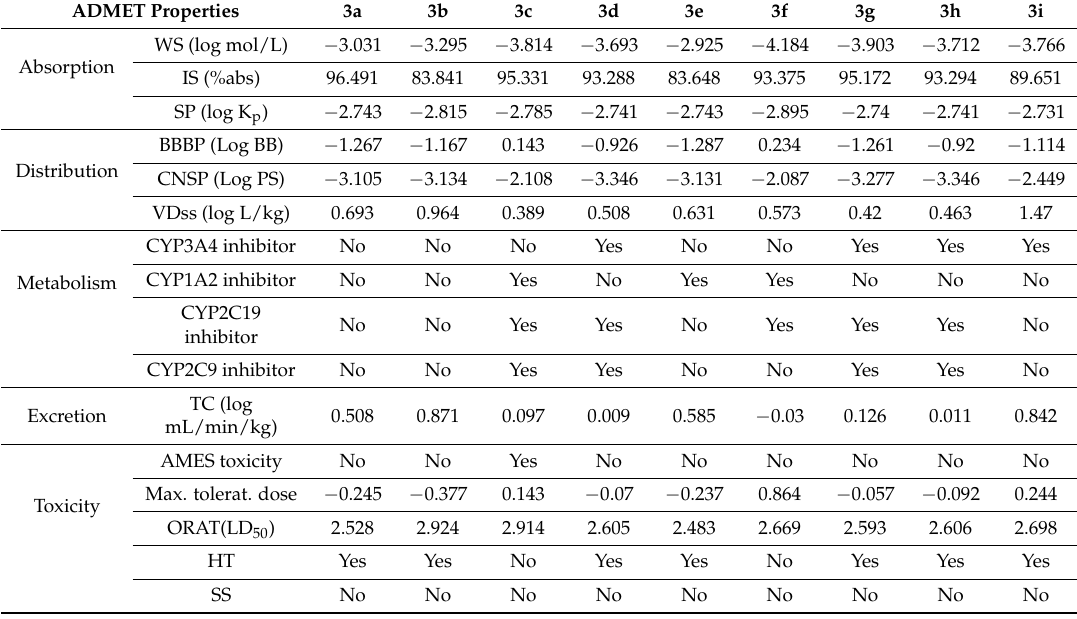
Table 4. Pharmacokinetic assessment of synthesized compounds.